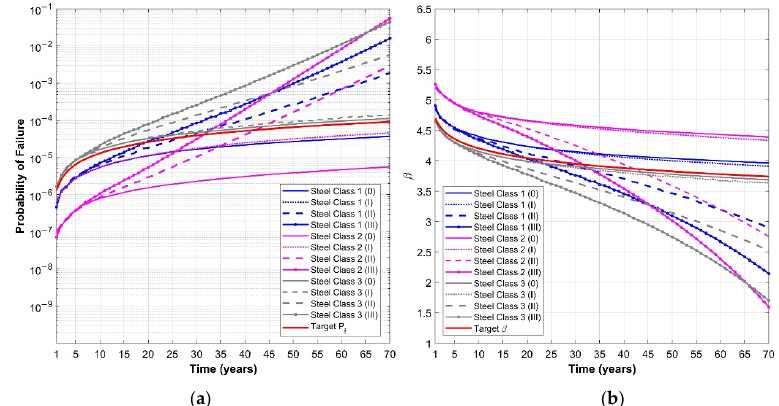
Figure 12. Time-dependent probability of failure ( a ) and reliability index 𝛽 ( b ) for shopping buildings (concrete class 2).